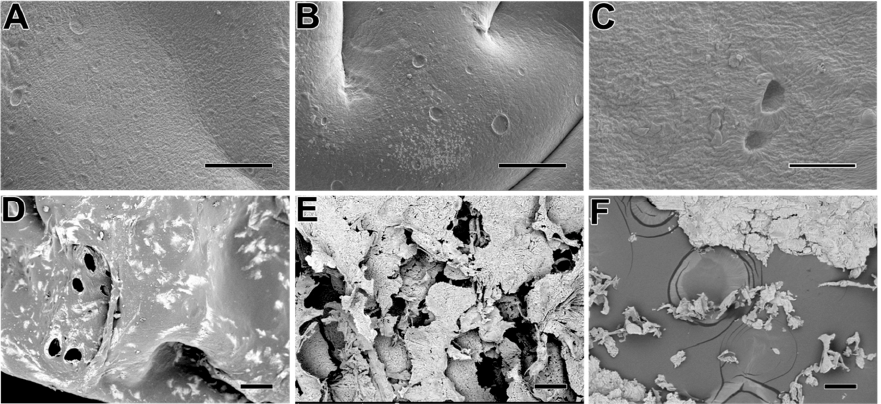
Figure 2. The different morphology of bFGF-Gel degraded after 0 days ( A ), 3 days ( B ), 6 days ( C ), 9 days ( D ), 12 days ( E ), 15 days ( F ) observed by SEM. The length of the scale bar is 100 μ